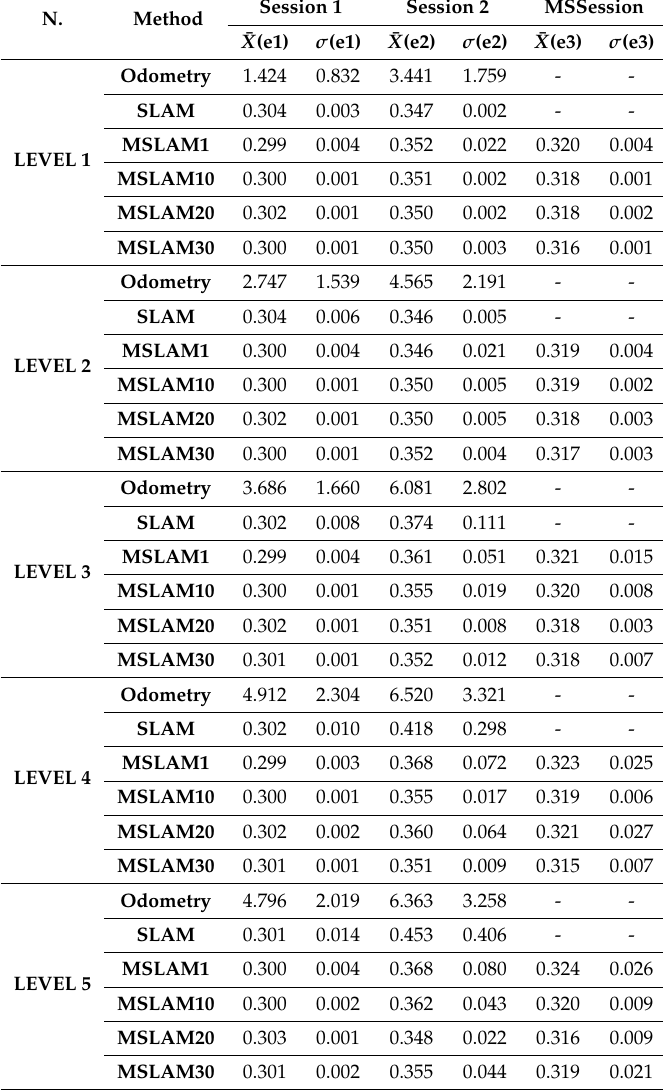
Table 3. Error ¯ X and σ of synthetically corrupted